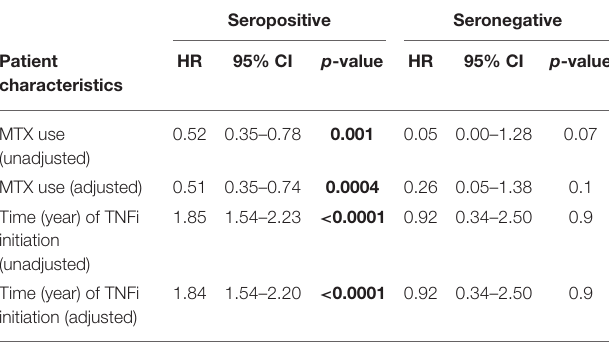
TABLE 2 | COX proportional hazard estimates (95% CI) for TNFi therapy survival, stratified by seropositivity.